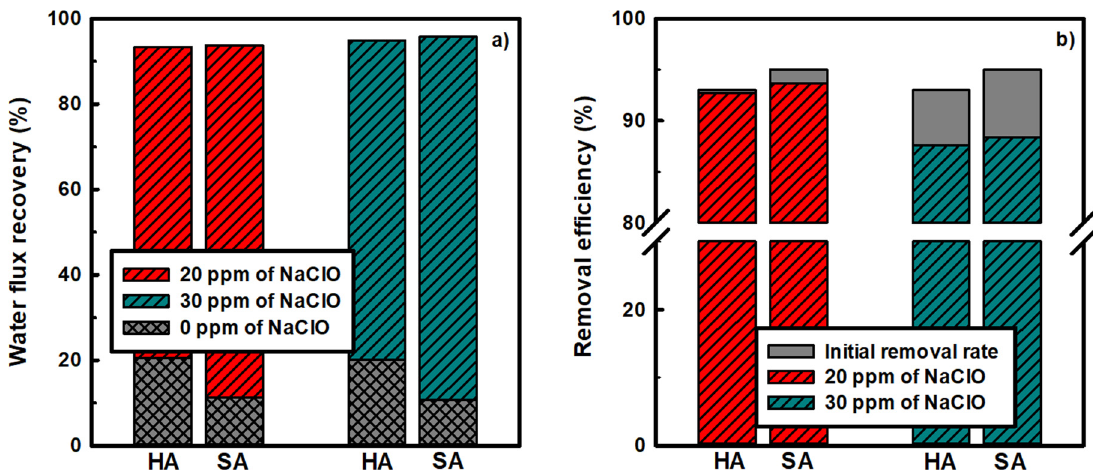
Figure 4. ( a ) Water flux recovery of the HA- and SA-fouled PAN-NF HF membrane after backwashing with NaClO solutions of different concentrations compared to water flux recovery using nonchemical backwashing. ( b ) Removal efficiencies of HA and SA from the PAN-NF HF membrane after backwashing with different concentrations of NaClO.